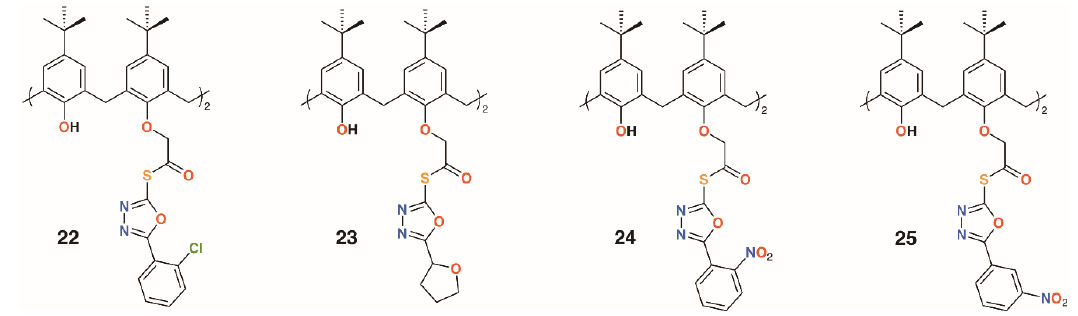
Figure 7. Dillmaghani’s aryl-oxadiazole derivatives.